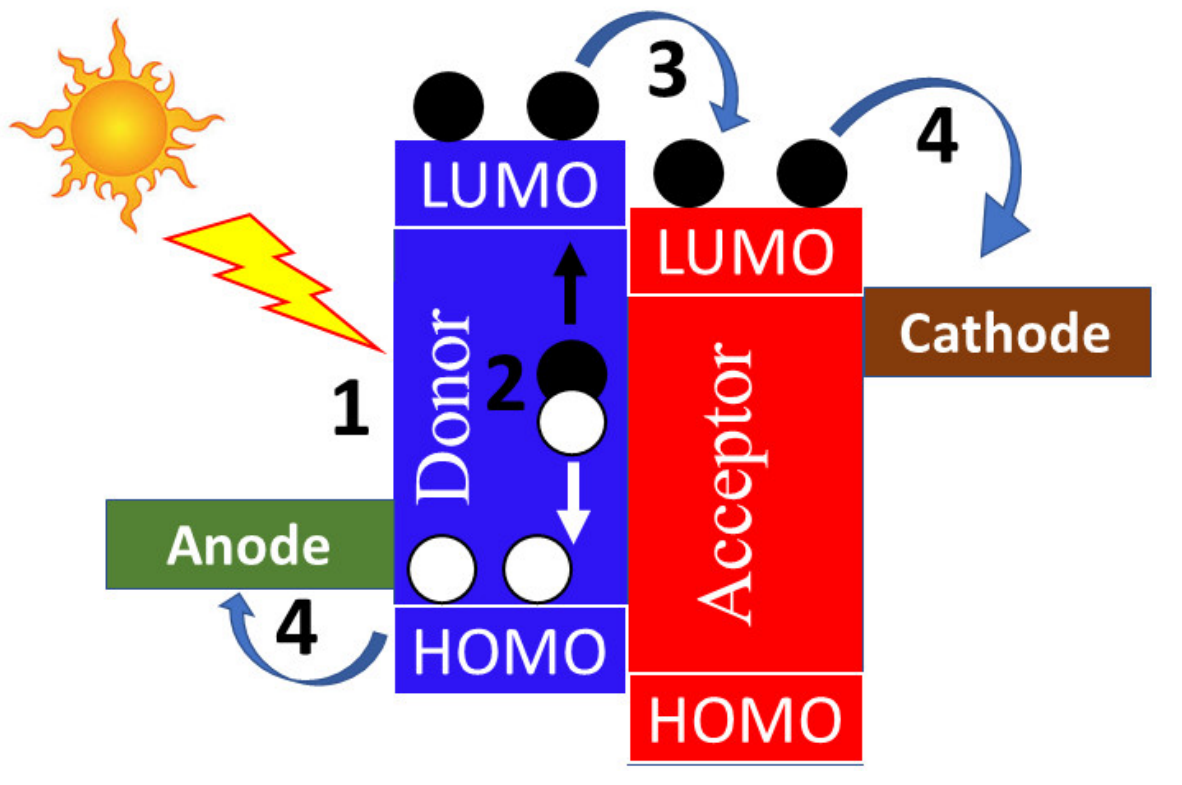
Figure 3 . Energy level diagram demonstrating the operation of